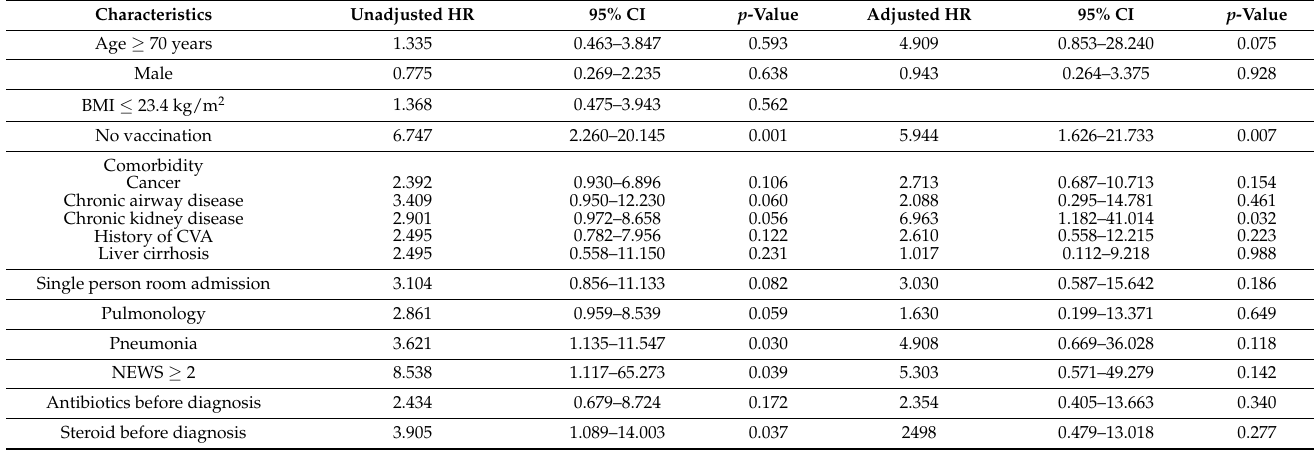
Table 3. Factors associated with mortality in patients with nosocomial COVID-19.